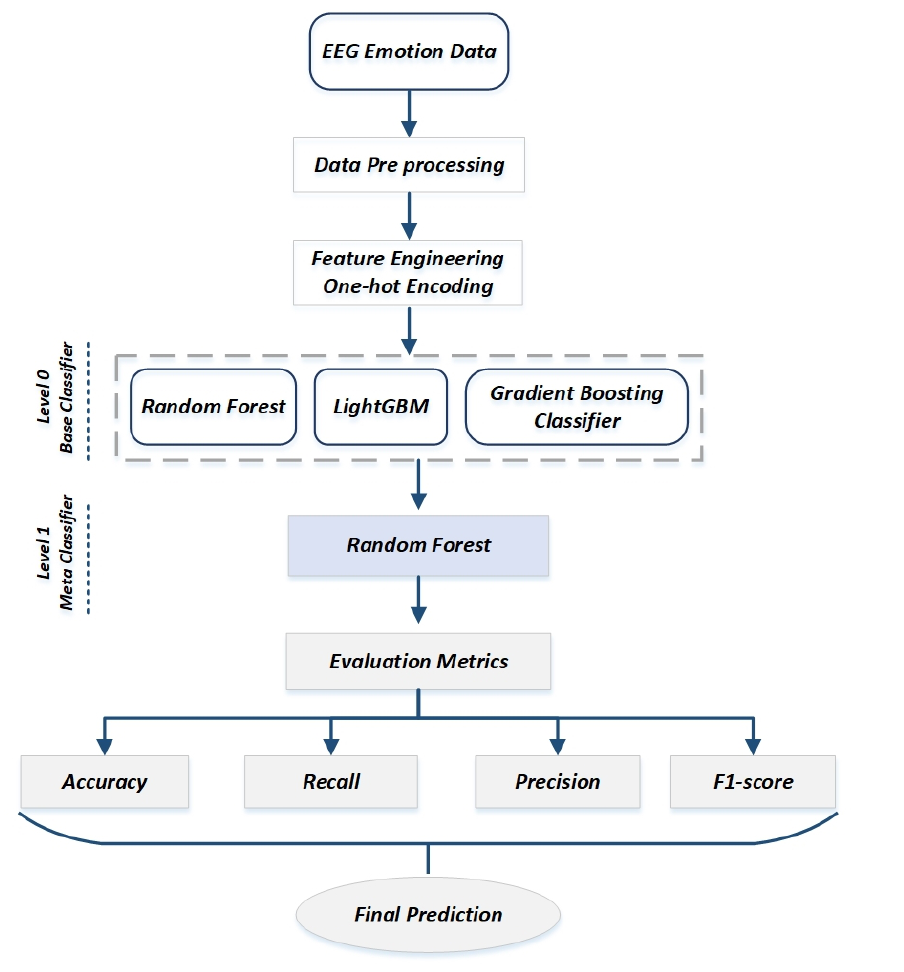
Figure 1. Base concept of proposed methodology. Table 1. The details used for EEG brainwave data